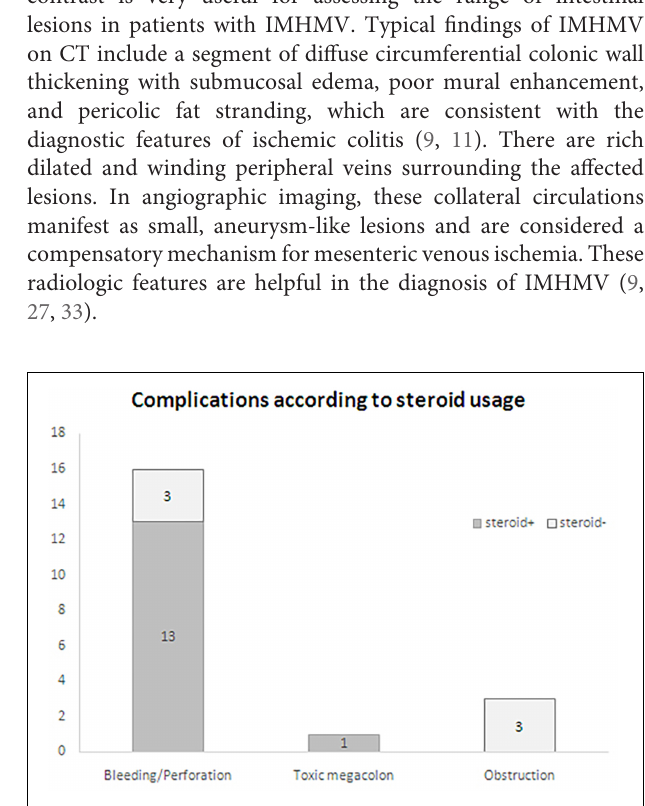
FIGURE 4 | Complications according to steroid